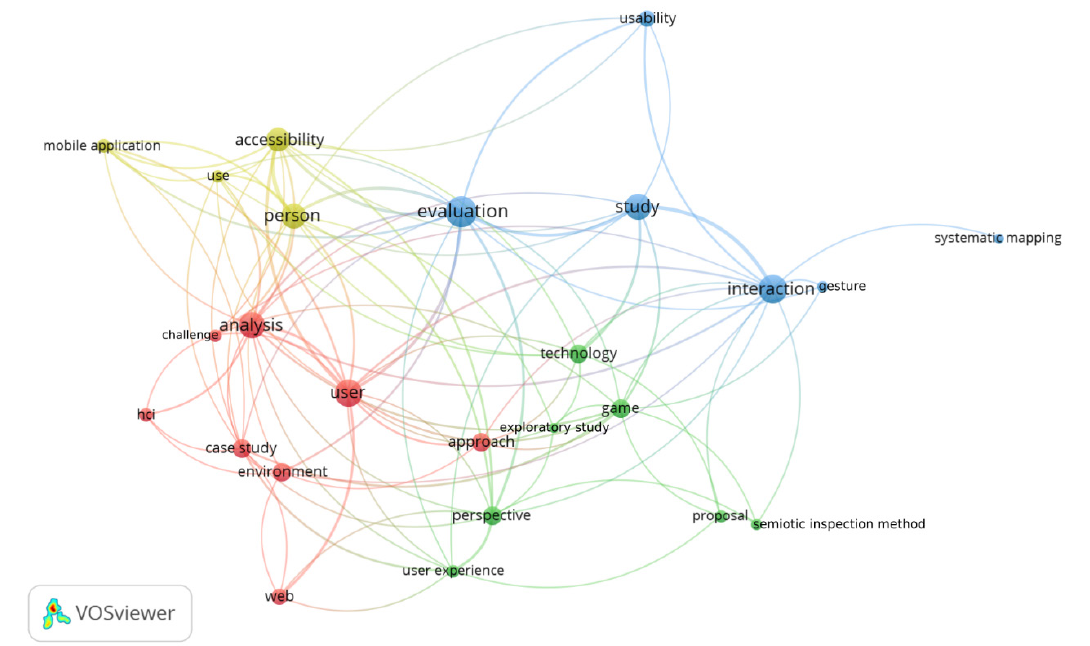
Figure 10. Correlation graph of the n5 (25) most recurring terms from